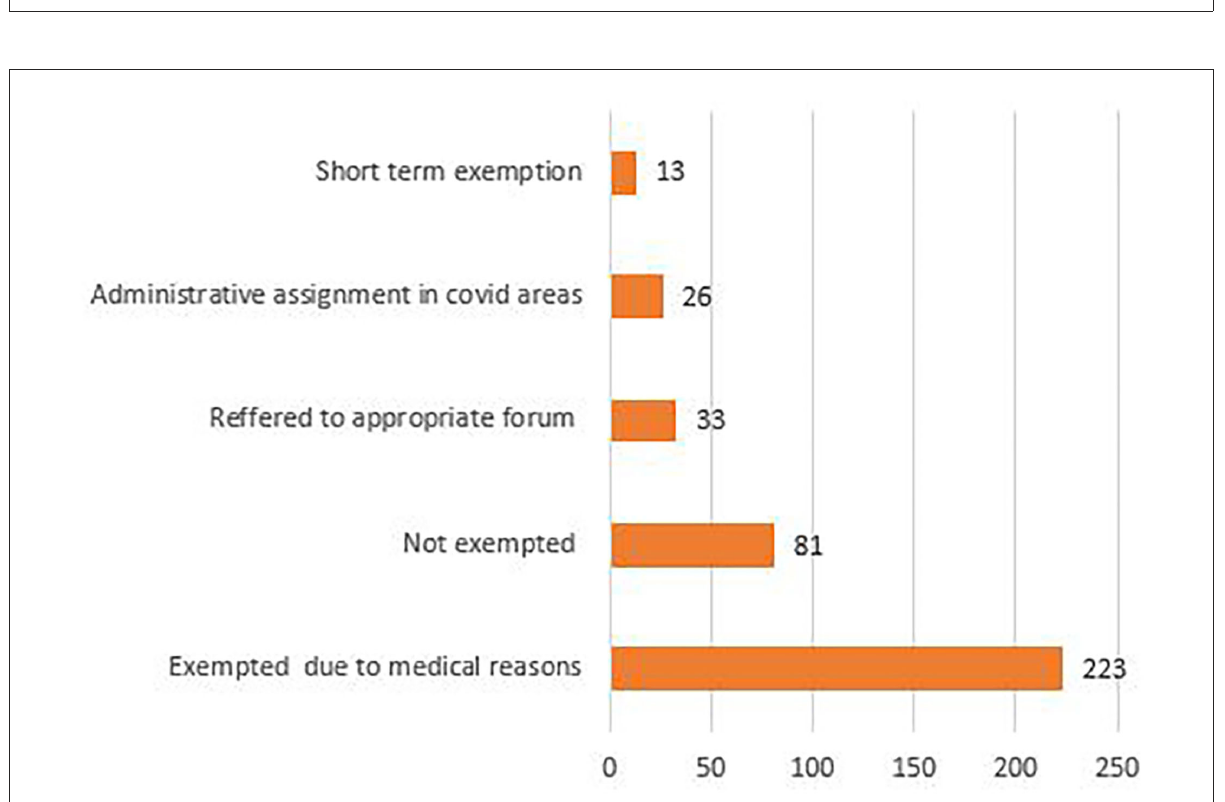
FIGURE4 Decision on exemption request under medical